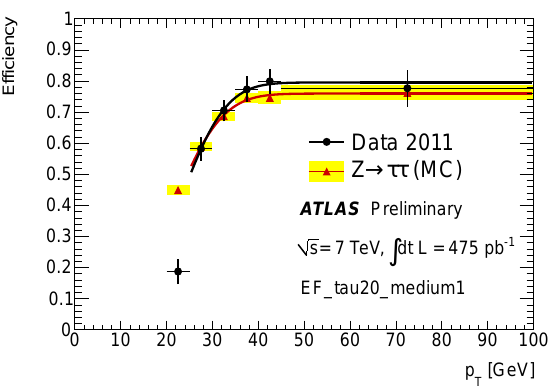
Fig. 2. Number of tracks of L2 taus for trigger taus in signal Monte Carlo and QCD di-jet data. The latter serves as back- ground estimate [2].